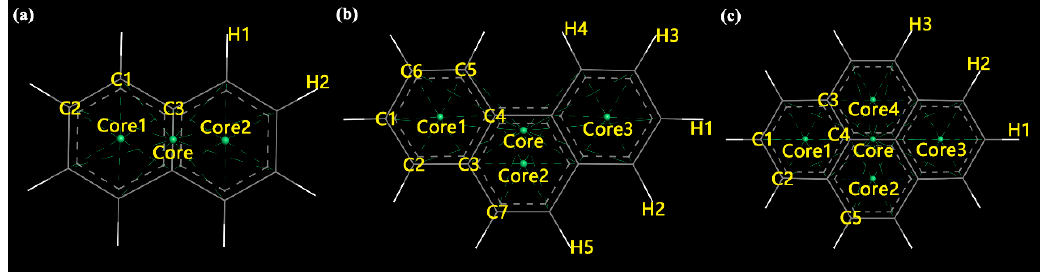
Figure 5. Graphical site description of polycyclic aromatic hydrocarbon (PAH) molecules. ( a ) naphthalene; ( b ) phenanthrene; ( c ) pyrene; Key: CoreX, the benzene ring center (X is the number); yellow, symbol of different atoms.